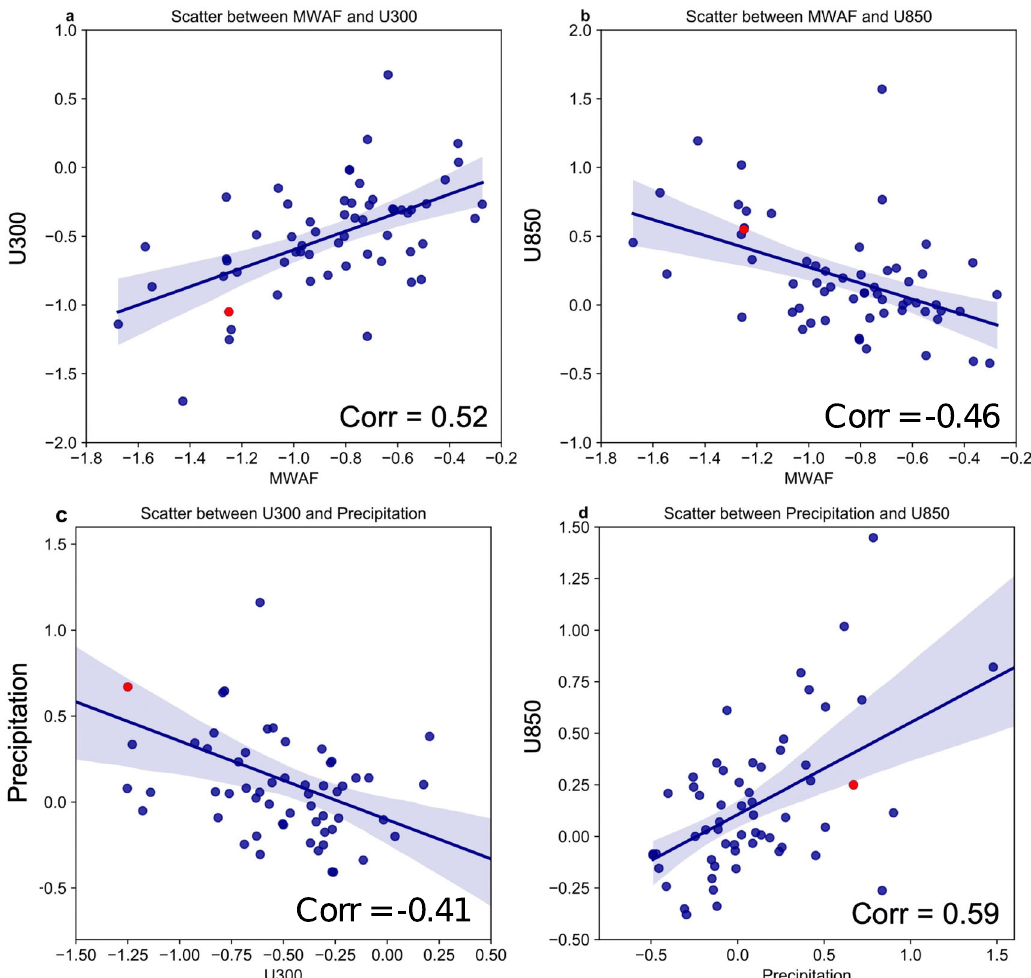
Fig. 6 Intermodel relationship of the MWAF versus winds and of precipitation versus winds for selected NPO events. a Scatter diagram between MWAF for NPO events and corresponding 300-hPa zonal wind anomalies D0JFM1-averaged over 130°E – 170°E, 5°S – 5°N. b The same as ( a ) but for the 850-hPa westerly wind anomalies averaged over 120°E – 160°E, 5°S – 5°N. c Same as ( a ) but for the precipitation averaged over 120°E – 160°E, 5°S – 5°N, and 300-hPa zonal wind anomalies. d Same as ( a ) but for the precipitation and 850-hPa wind anomalies. The red dots show the observations while the blue dots represent the CMIP5/6 models. Linear regression lines are shown with their 90% con fi dence intervals (shaded) using the bootstrap